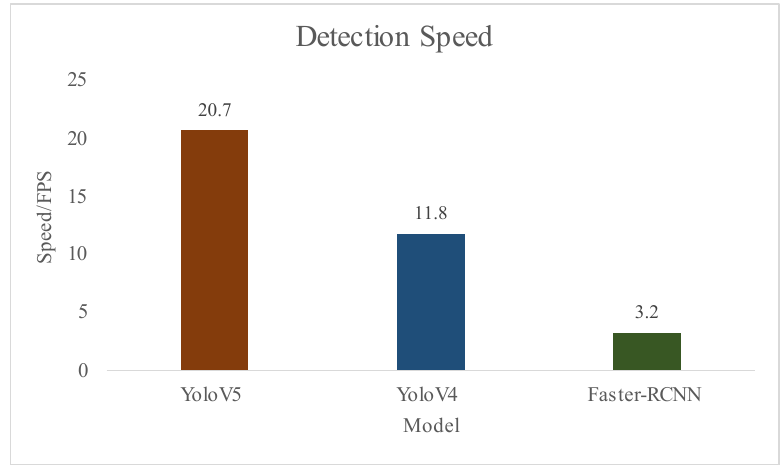
Figure 13. The histogram of detection speed.